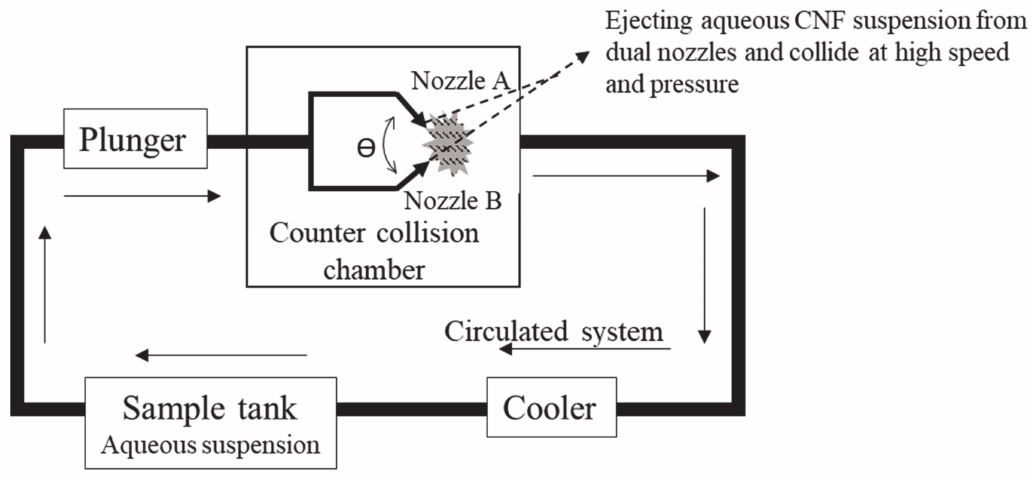
Figure 1. Illustration of the aqueous counter collision (ACC)